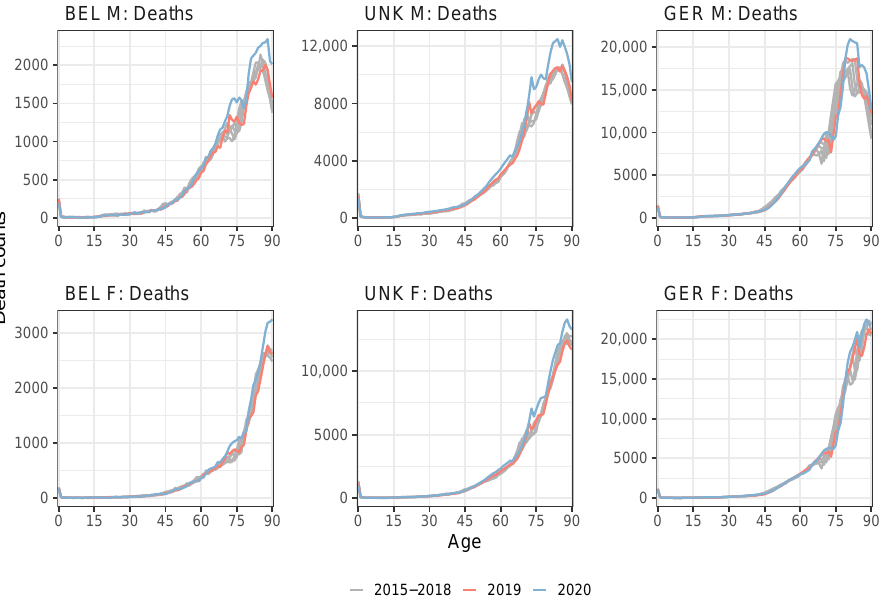
Figure 5. (Virtual) annual death counts d x , t for males ( top ) and females ( bottom ) in Belgium ( left ), the United Kingdom ( middle ) and Germany ( right ) as a function of age, years 2015-2020. Death are directly available from the HMD, Eurostat or Statbel. However, for the year 2020 (Germany) and the years 2019–2020 (United Kingdom), we transform the weekly deaths collected in age buckets from the STMF data series or Eurostat to deaths at individual